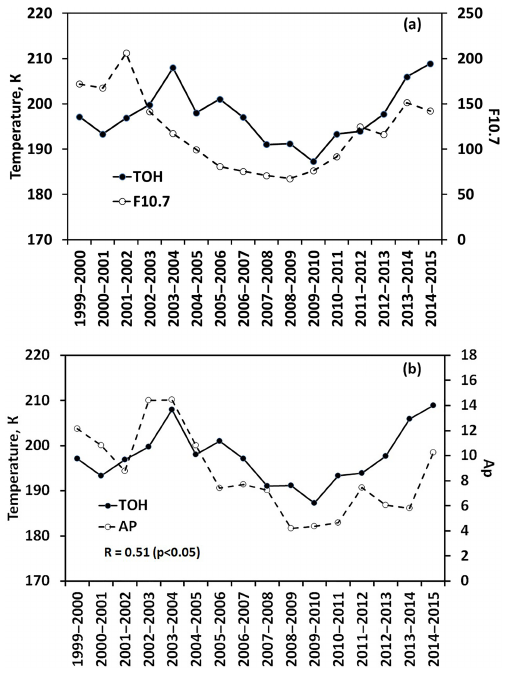
Figure 2. (a) Seasonally averaged TOH and F10.7 index (from Au- gust to May) for 1999–2015. (b) The TOH and Ap index mean val- ues for 1999–2015. The average values of the F10.7 index and Ap index were calculated in the days that coincided with the TOH mea- surements at the Maimaga station.